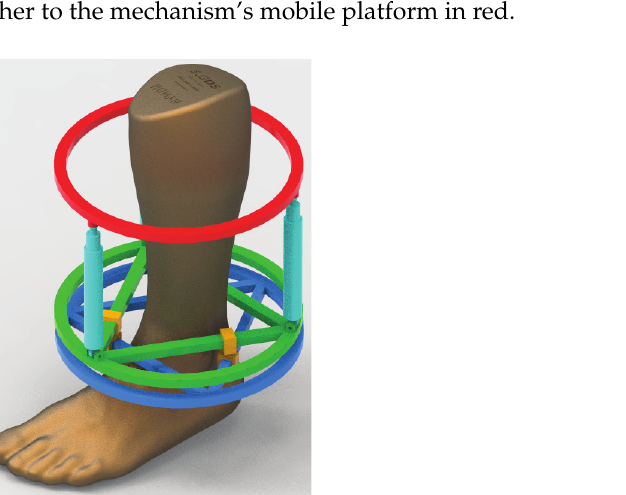
Figure 1. Robot mechanism for bone reduction surgery.